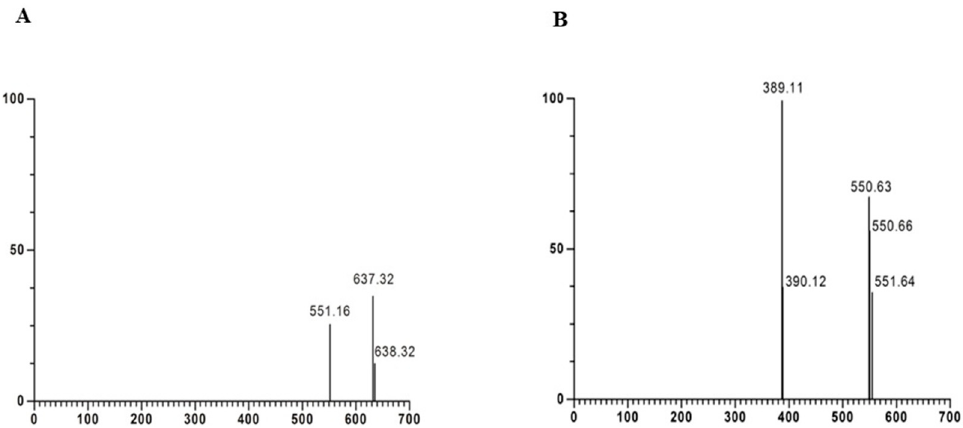
Figure 2. Identification of purified betanin by HPLC-ESI(+)-MS/MS. ( A ) betanin m / z 551 [M + H] + , ( B )